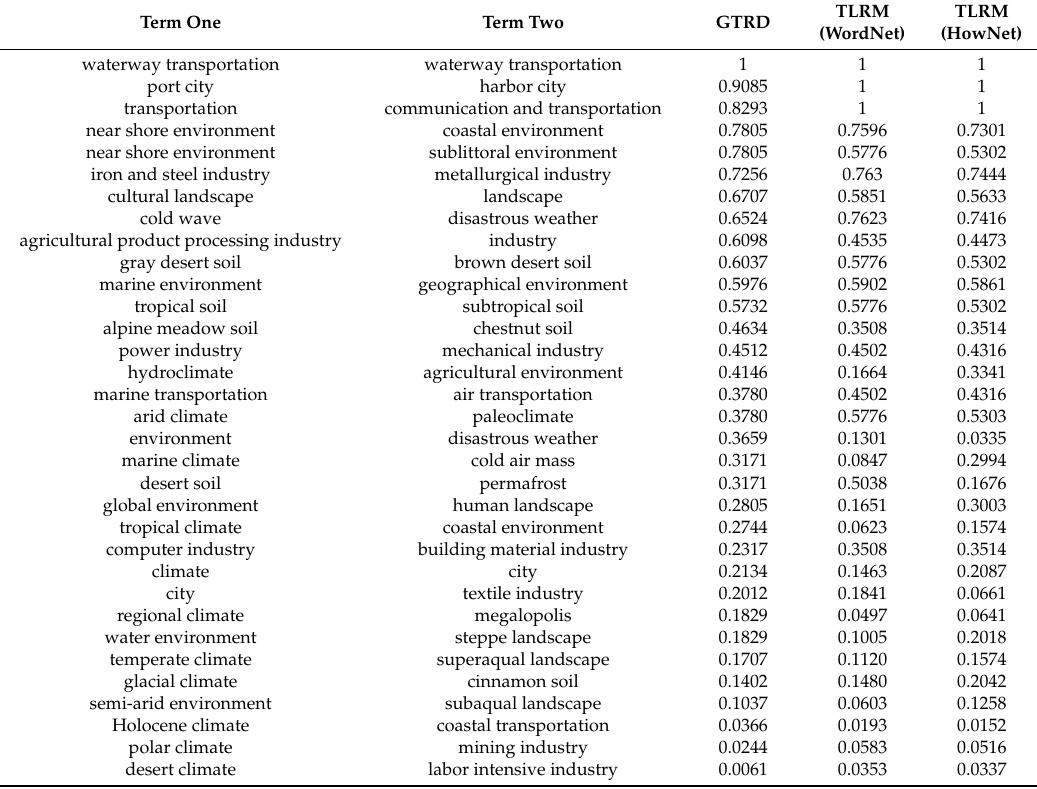
Table 3. The relatedness generated by the thesaurus–lexical relatedness measure (TLRM) and expert ratings on evaluation